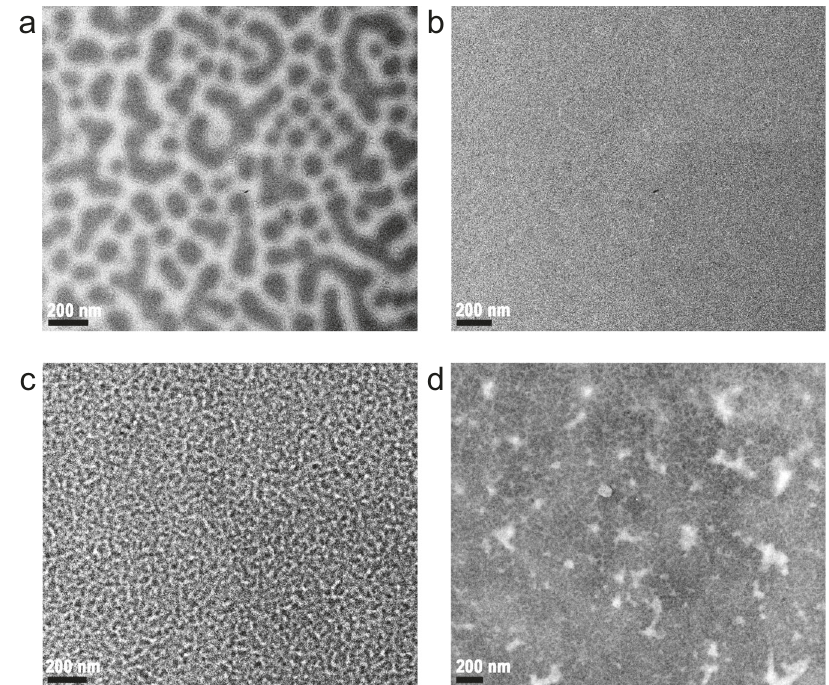
Fig. 6 Transmission electron microscopy (TEM) images. Morphology of DPPEZnP-TEH:PC 61 BM a as-cast thin fi lm, b pyridine additive processed thin fi lm, c pyridine additive processed thin fi lm after thermal annealing, and d pyridine and 1,8-diiodooctane (DIO) dual additive processed fi lm after thermal annealing. Adapted with permission from ref. 20 and ref. 21 . Copyright (2015) American Chemical Society and (2016) WILEY-VCH Verlag GmbH & Co. KGaA,